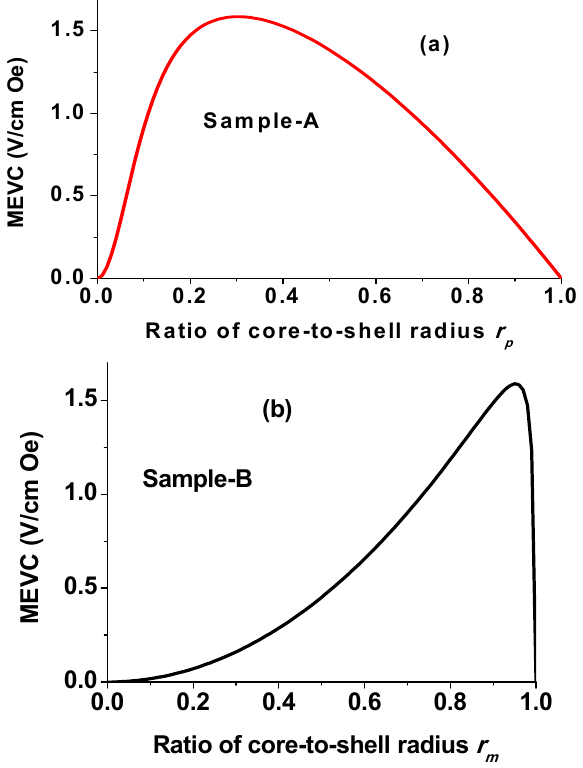
Figure 8. Estimated ME voltage coefficient as a function of the ratio of core-to-shell radius for fibers of ( a ) BTO core and NFO shell and ( b ) NFO core and BTO shell.